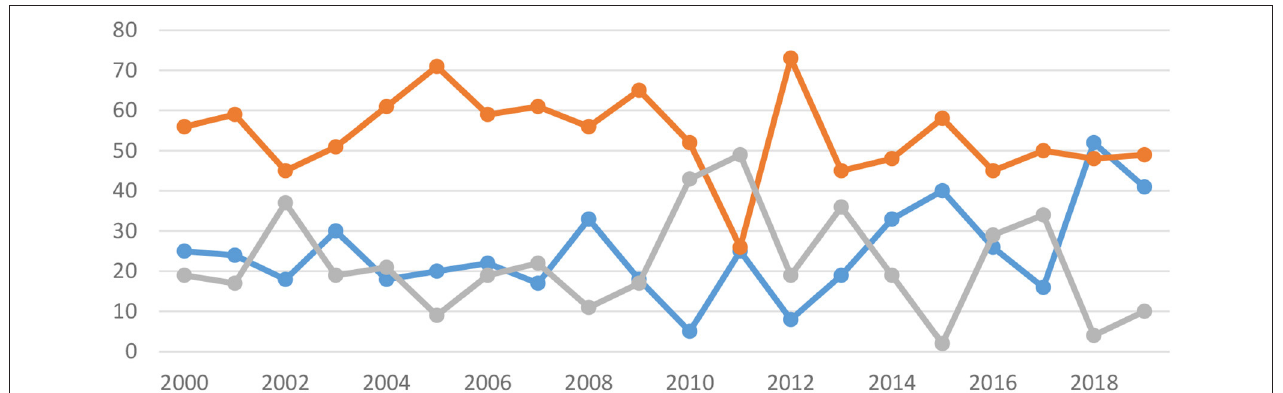
FIGURE 7 | Political risk in Brazil from 2000 to 2019.